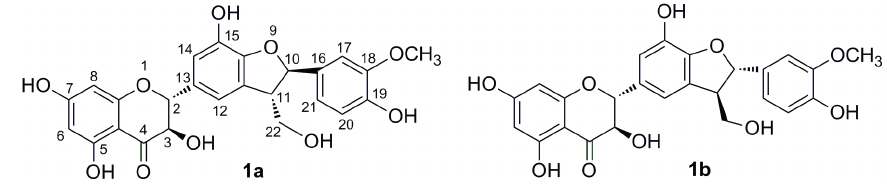
Figure 1. Structures of silychristin A ( 1a ) and silychristin B ( 1b